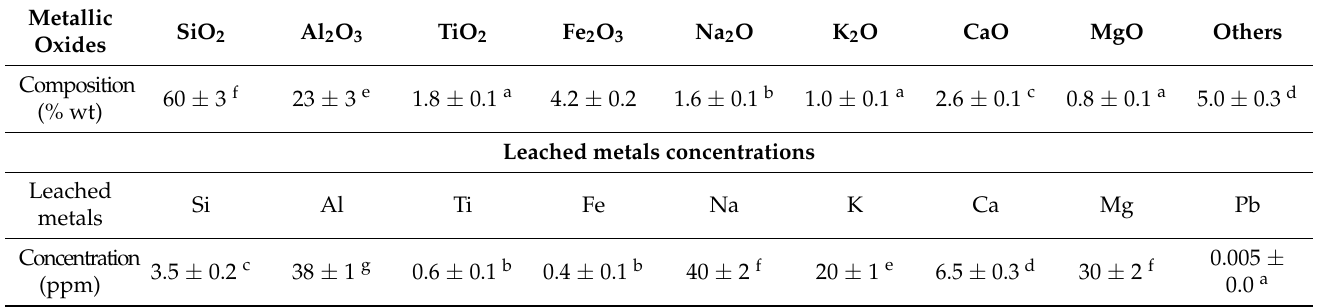
Table 2. Chemical analysis of the RFA used for